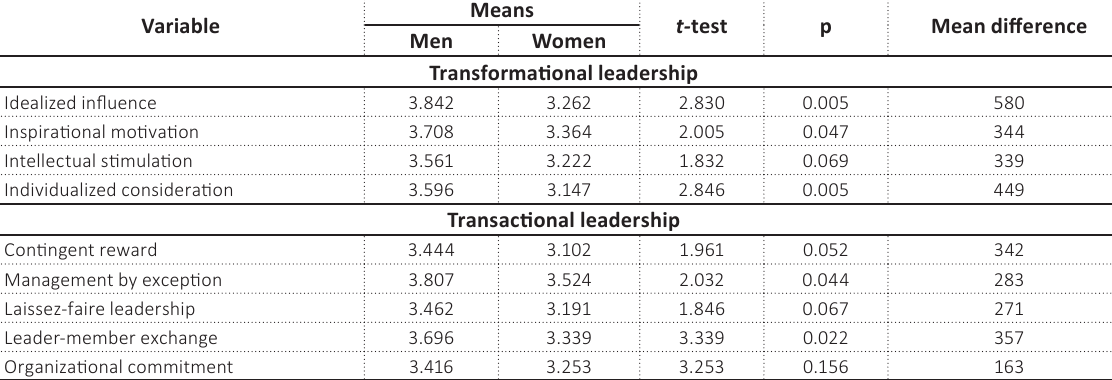
Table 5. Comparison between women and men’s perceptions about leadership, LMX and organizational commitment